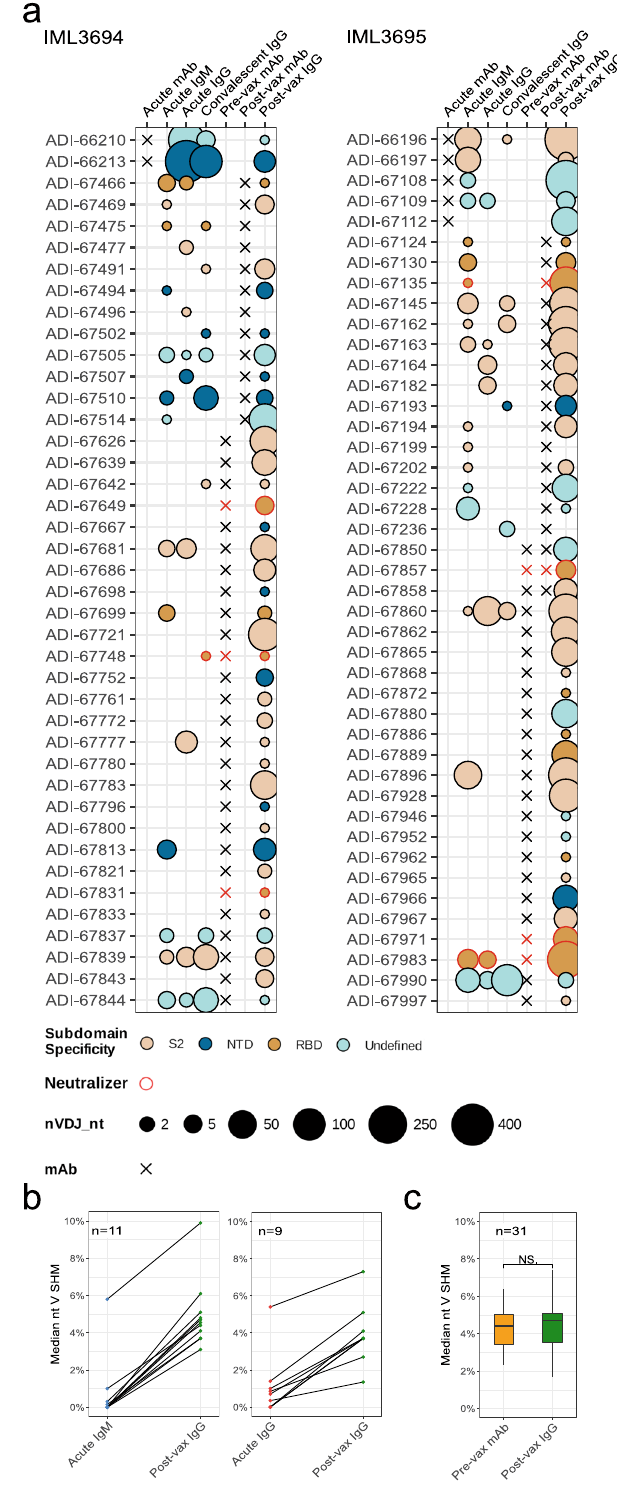
Fig. 5 | IgM and IgG repertoire sequencing and lineage tracing of SARS-CoV-2 S-speci fi c antibody lineages at the longitudinal timepoints. a Bubble plots of SARS-CoV-2S-speci fi cmAblineagesfoundbeforeandaftervaccinationinIML3694 and IML3695.The bubble sizes correspond to post-FAD and chimera-cleaneddata. b Line plotsofmedian% nucleotide IGHV SHM forlineages found inacute IgM/IgG and post-vax IgG Rep-seq data. c Boxplot of median % nucleotide IGHV SHM for lineages containing pre-vax timepoint mAbs and post-vax IgG Rep-seq. The box represents the median±interquartile range and the whiskers represent the max- imum and minimum values. A two-sided Wilcoxon signed-rank test was used for comparison; P